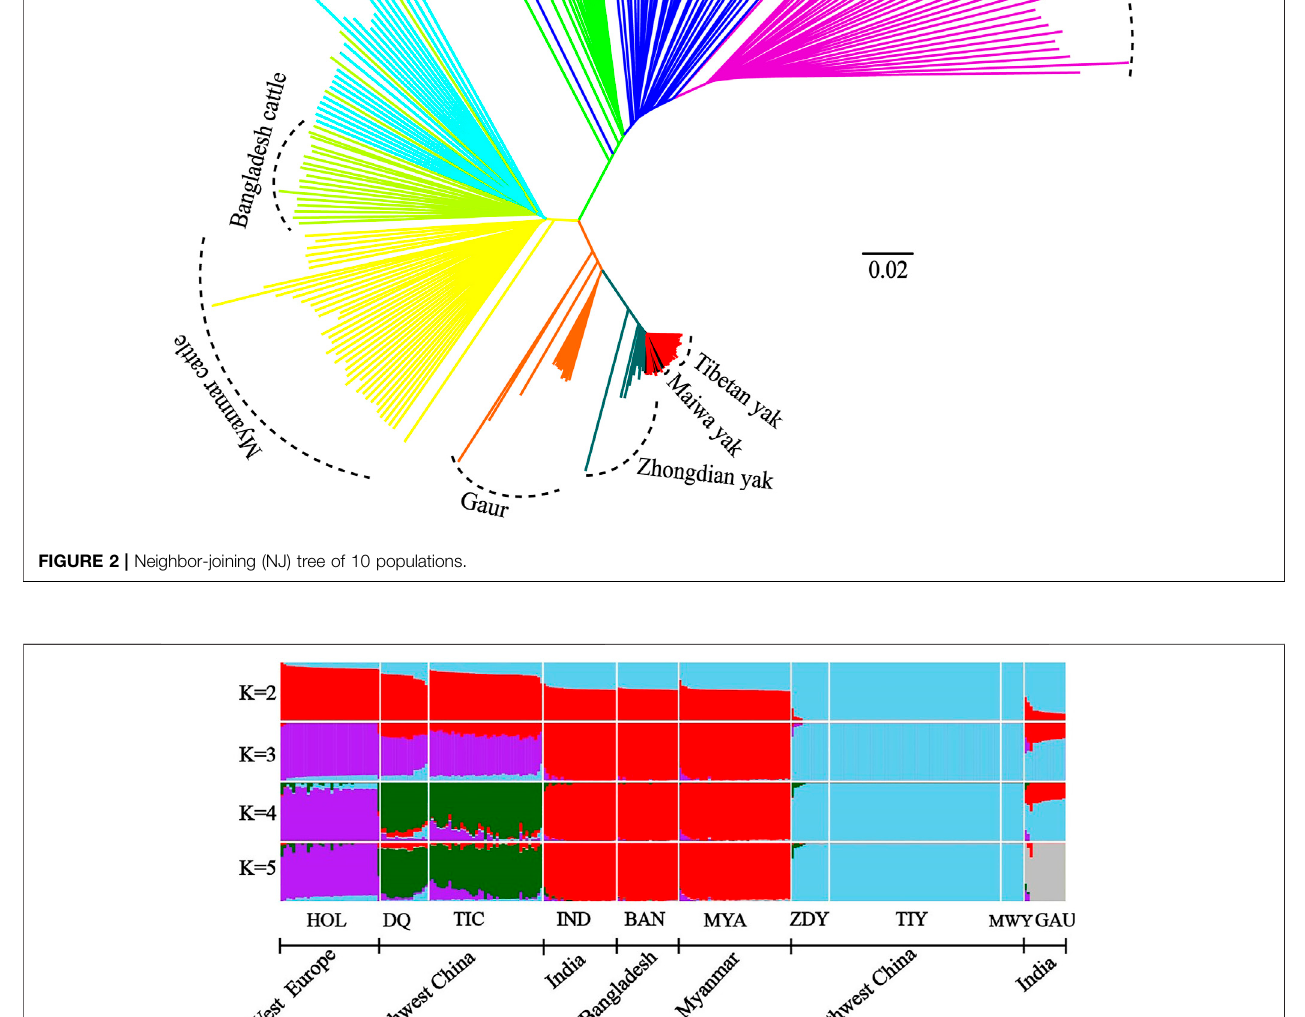
The same methods ( f3 statistics, D statistics, and TreeMix analyses) were used to detect the genetic introgression from Diqing cattle to the Zhongdian yak. When using the Tibetan